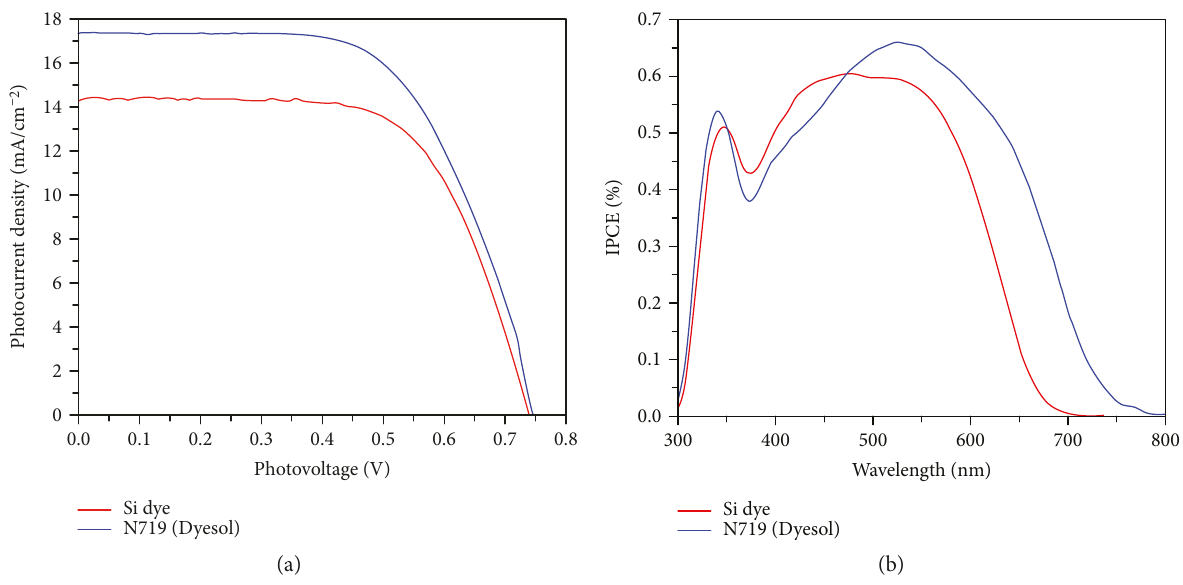
Figure 7: (a) J-V characteristics of N719 and Si dye (CL-1)-sensitised DSSC under standard AM 1.5 testing conditions. Si dye showed a V J , FF, and η (%) of 0.742, 14.4, 65, and 6.90, respectively. N719 showed a V sc IPCE spectra of these cells displayed an increased absorbance over the spectral region (500 – 750 nm) for N719, but a relatively lower absorbance in the 400 – 470 nm region compared with Si